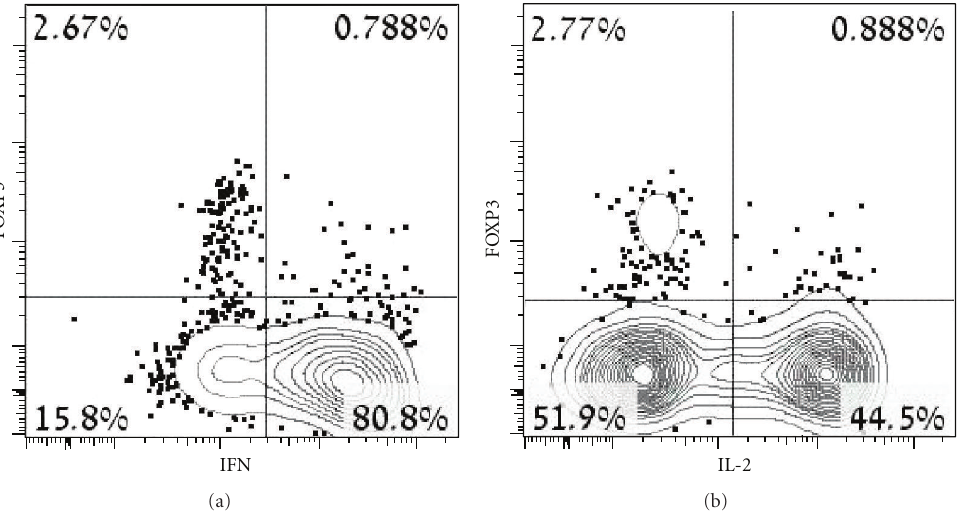
Figure 5: IFN γ and IL-2 cytokines secretion following T-cell stimulation. PBMCs obtained from patient 2 were stimulated with PMA and ionomycin, than stained with CD4, FOXP3, and IFN γ or IL-2 for the identification of functional Tregs. Detection was performed using FACS analyses. Quadrants were set up based on staining with isotype control. Boxed numbers indicate the percentage of cells within the CD4 + population that secrete IFN γ or